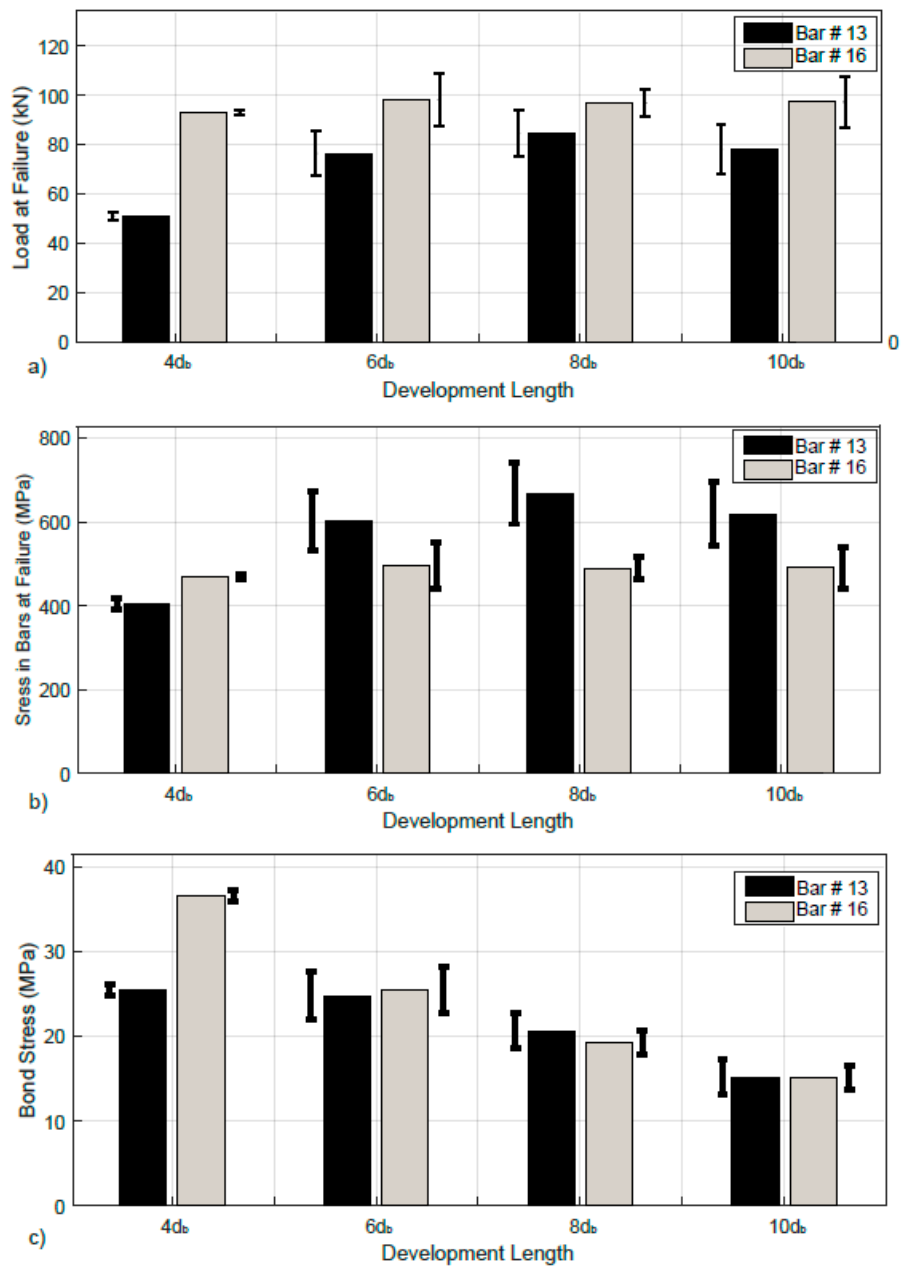
Figure 6. Pull-out test results for bar #13 (12.7 mm) and #16 (15.9 mm): ( a ) load at failure; ( b ) stress in bar at failure; ( c ) bond stress.